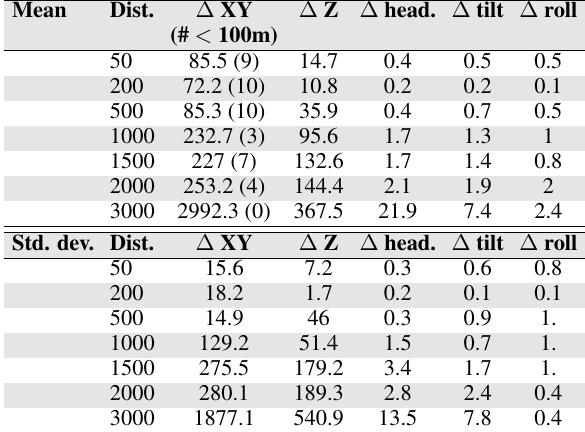
Impact of the geotag on the pose accuracy. For a same image, the initialisation location is generated at different distances. Distances are measured in meters, angles in